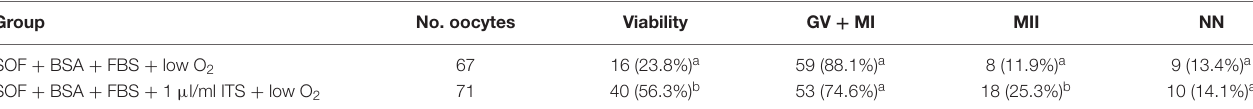
Viability and IVM of oocyte after co-staining with propidium iodide (PI) and Hoechst 33342 to determine maturation and cell membrane integrity. The percentages of oocytes in the germinal vesicle or metaphase I (GV + MI), metaphase II (MII), and non-identifiable (NN) stages were recorded simultaneously with cell membrane integrity evaluation after 48 h of IVM. In the same column, percentages with different superscripts differed significantly ( a , b p < 0.05). The experiments were repeated three times (n = 3). BSA, bovine serum albumin; FBS, fetal bovine serum; IVM, in vitro maturation; ITS, insulin-transferrin-selenium; SOF, synthetic oviductal fluid.